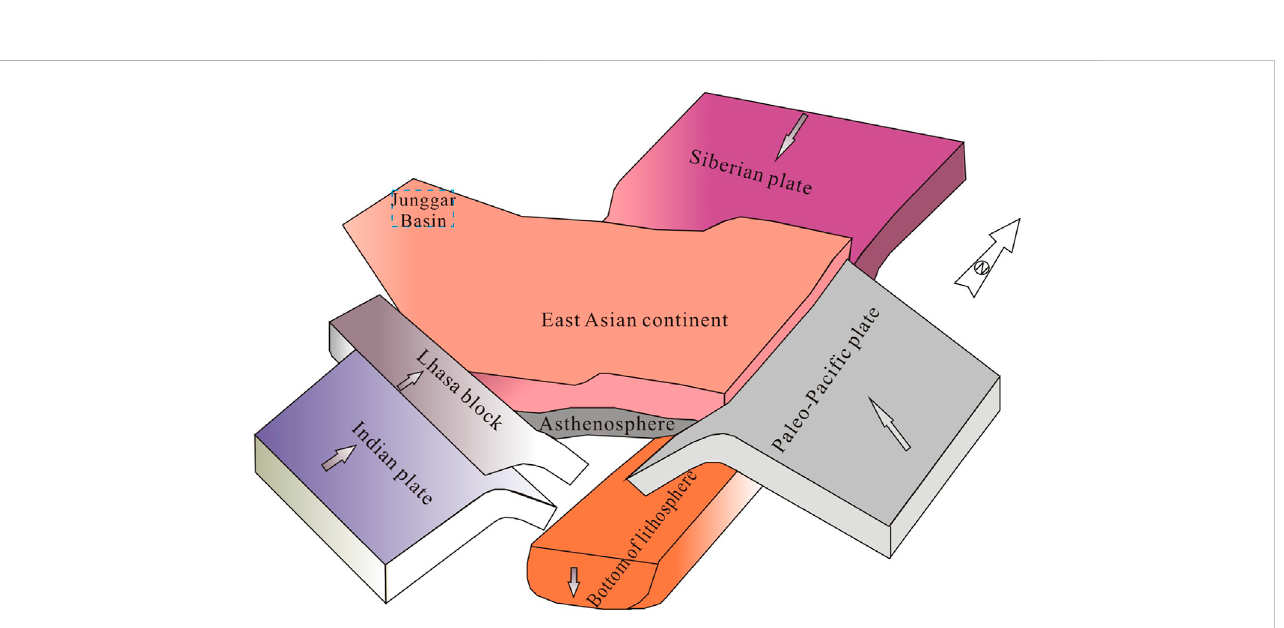
FIGURE 9 Schematic diagram of Mesozoic multi-plate convergence in East Asia